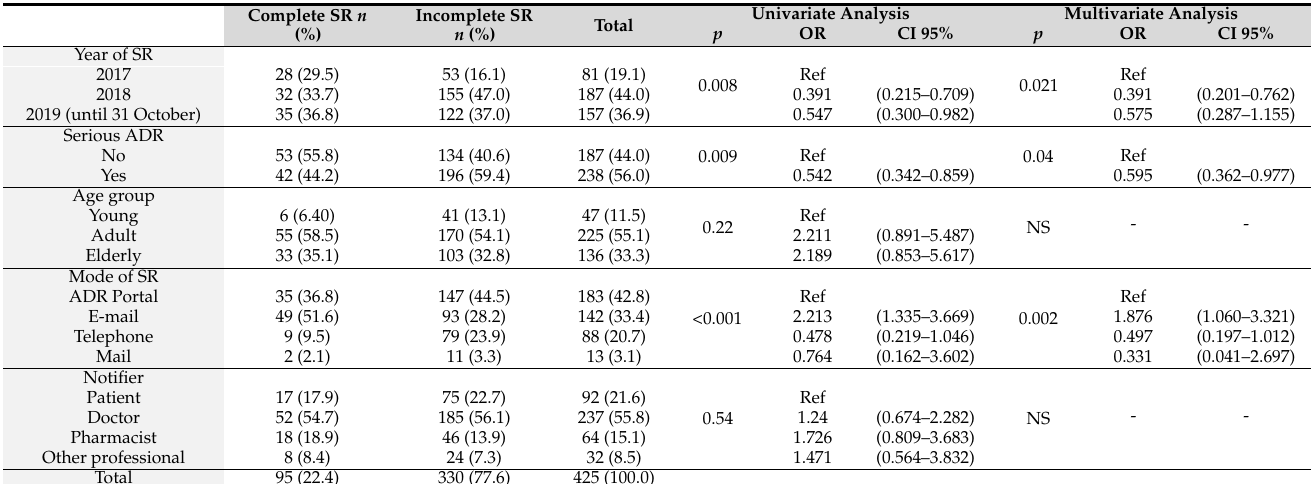
Univariate Analysis Multivariate AnalysisComplete SR n